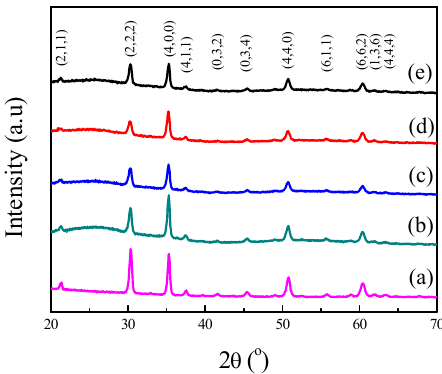
Figure 2. The X ‐ ray diffraction (XRD) patterns of electrochromic films: ( a ) ITO, ( b ) WO 3 , ( c ) LW1, ( d ) LW2, ( e ) LW3.